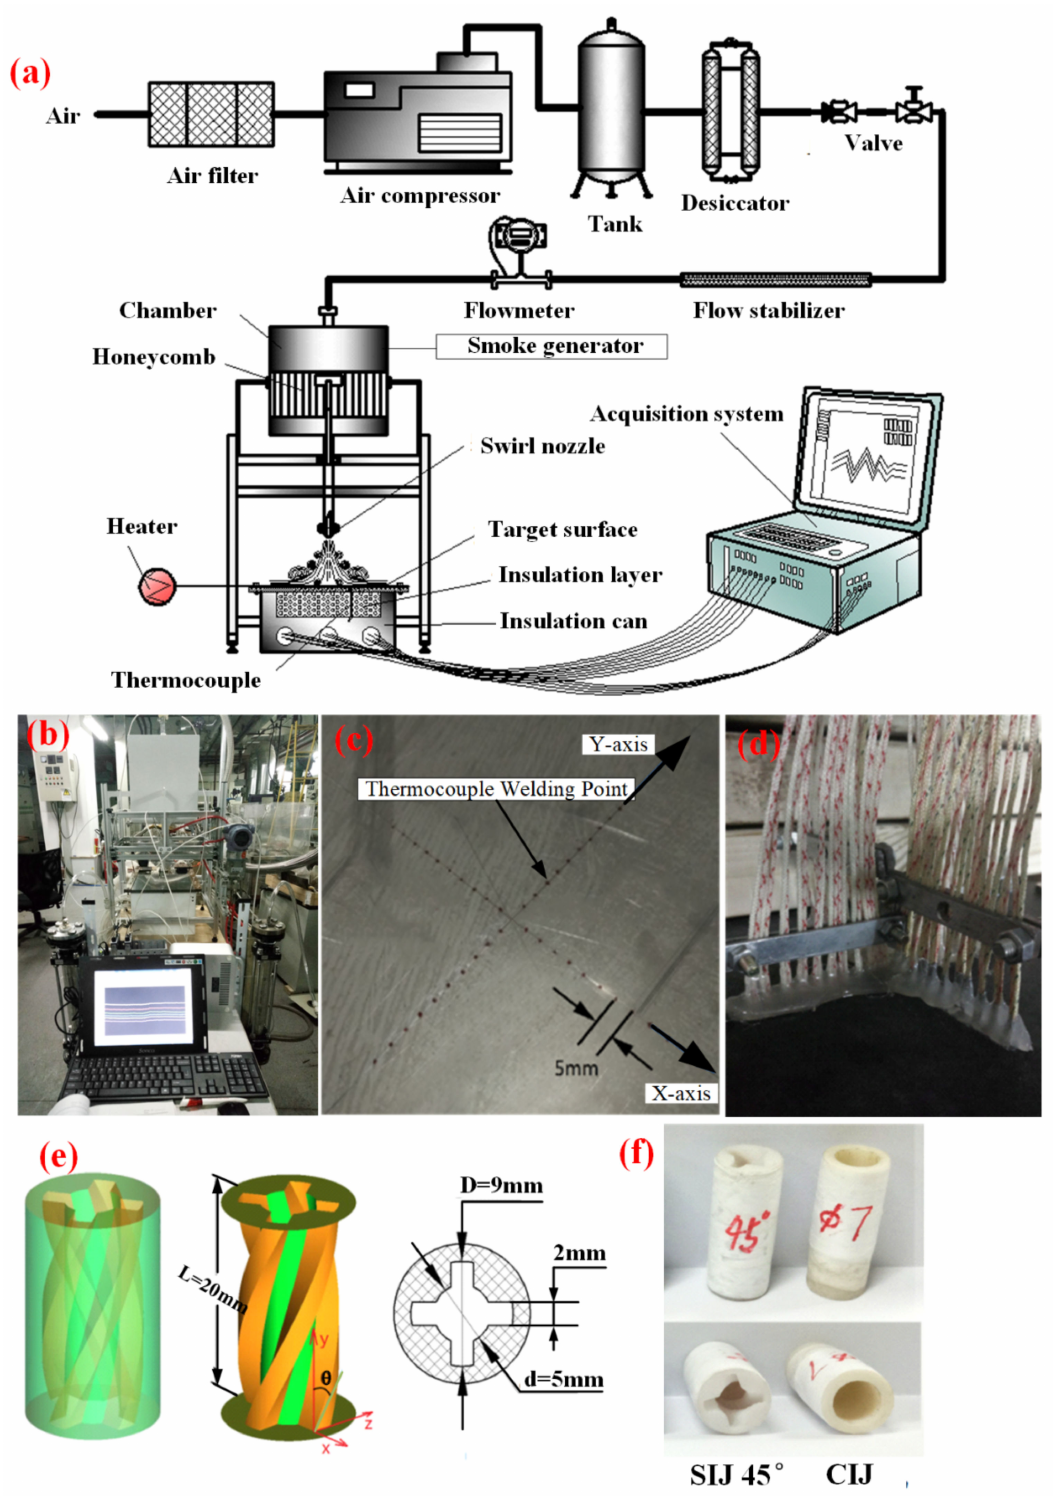
Figure 1. ( a ) Scheme of the experimental device, ( b ) picture of the experimental device, ( c ) points of thermocouples, ( d ) fixation of thermocouples, ( e ) schematic diagram of nozzle, and ( f ) real picture of